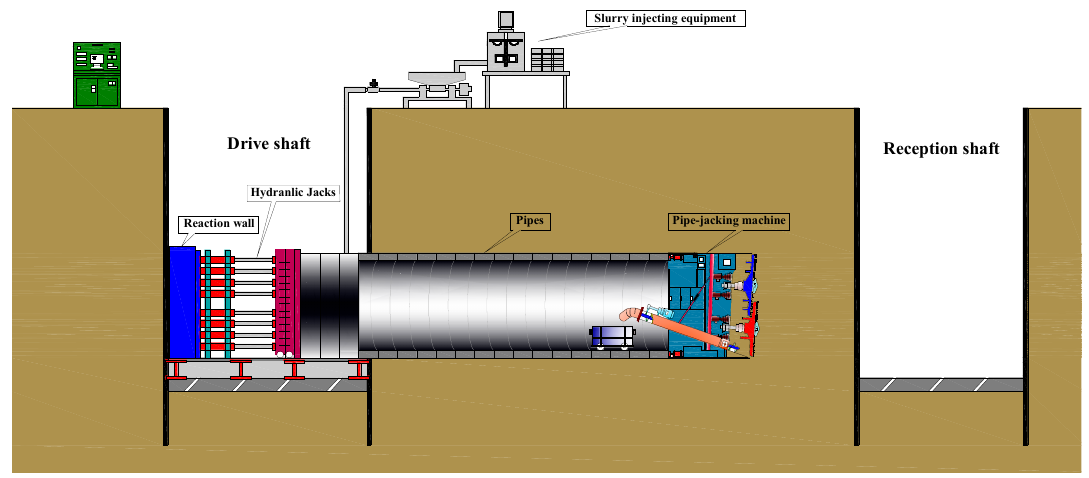
Figure 1. Schematic of slurry pipe jacking.